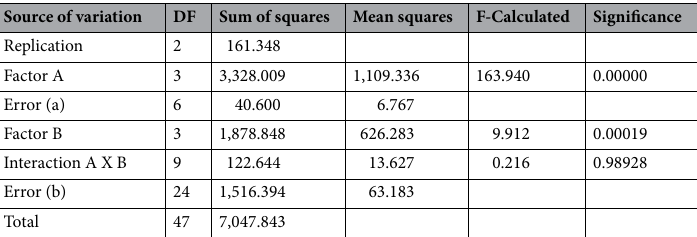
Table 14. Analysis of variance for effect of operating parameters on paddy residue size reduction. Factors A and B combine horizontal & vertical clearance and forward speed, respectively.